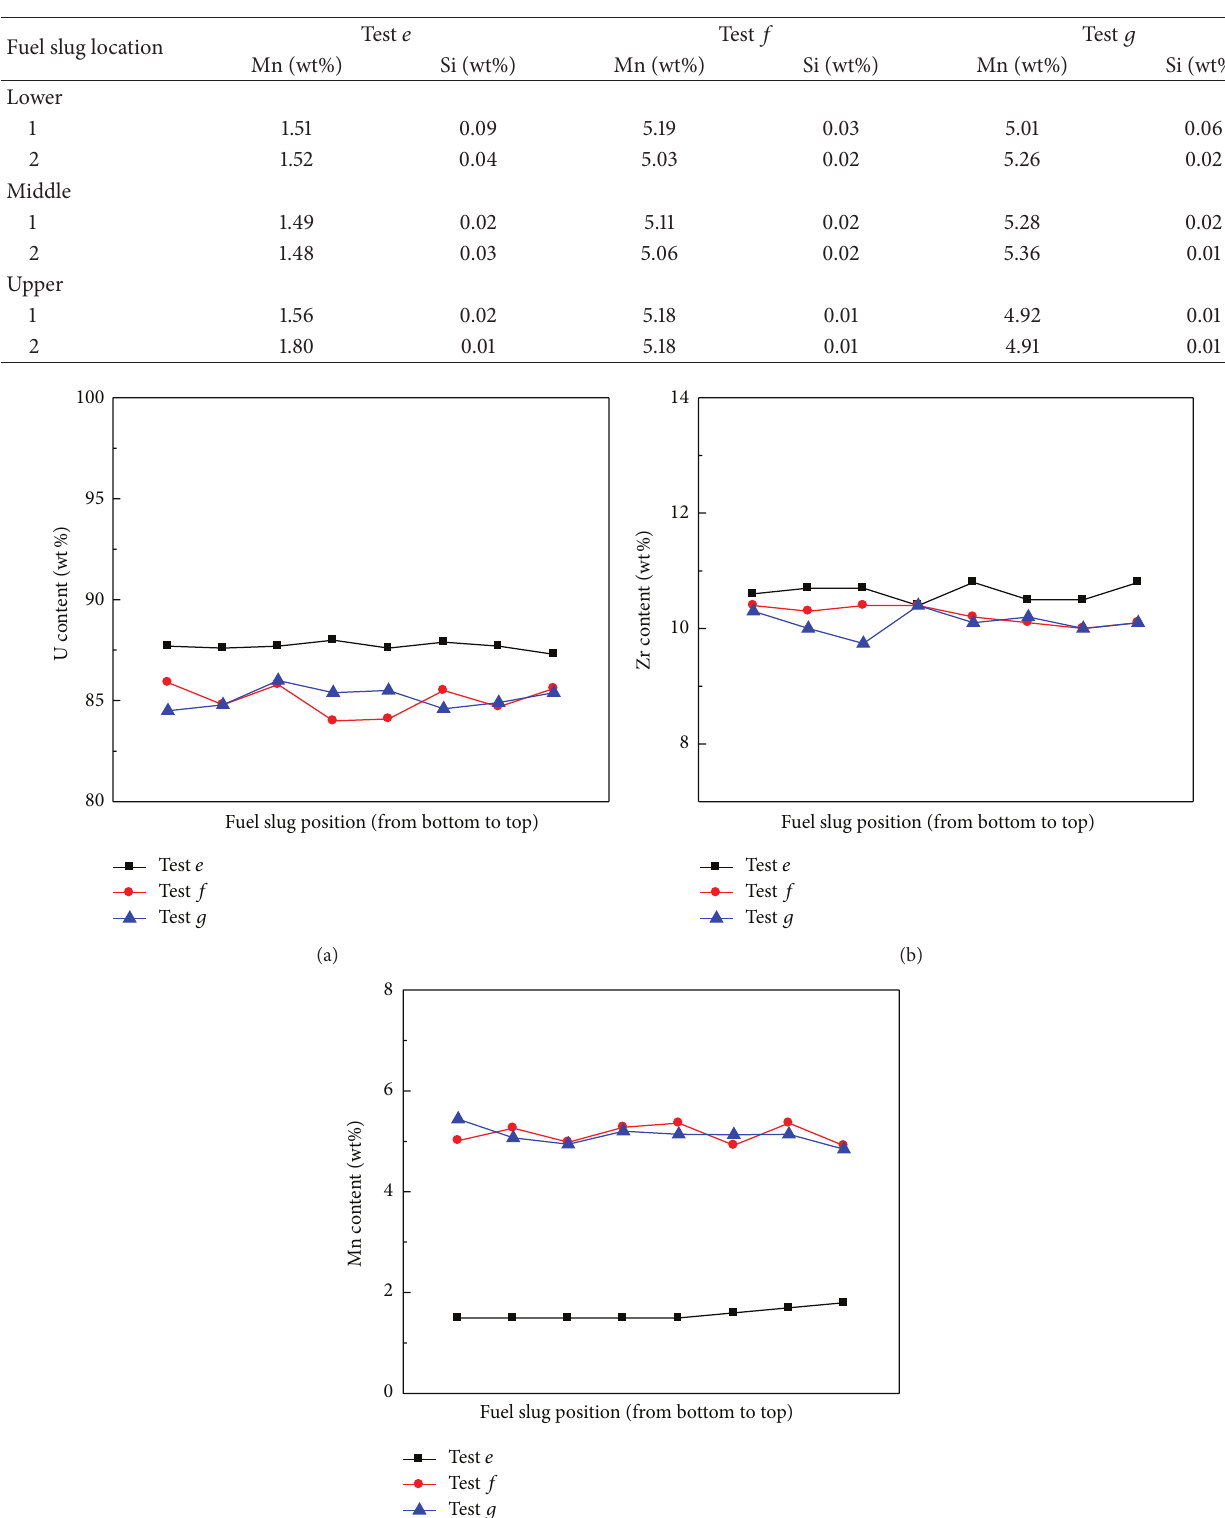
Table 2: Concentrations of Mn and Si according to position of U–10Zr–5Mn fuel slugs prepared by injection casting.